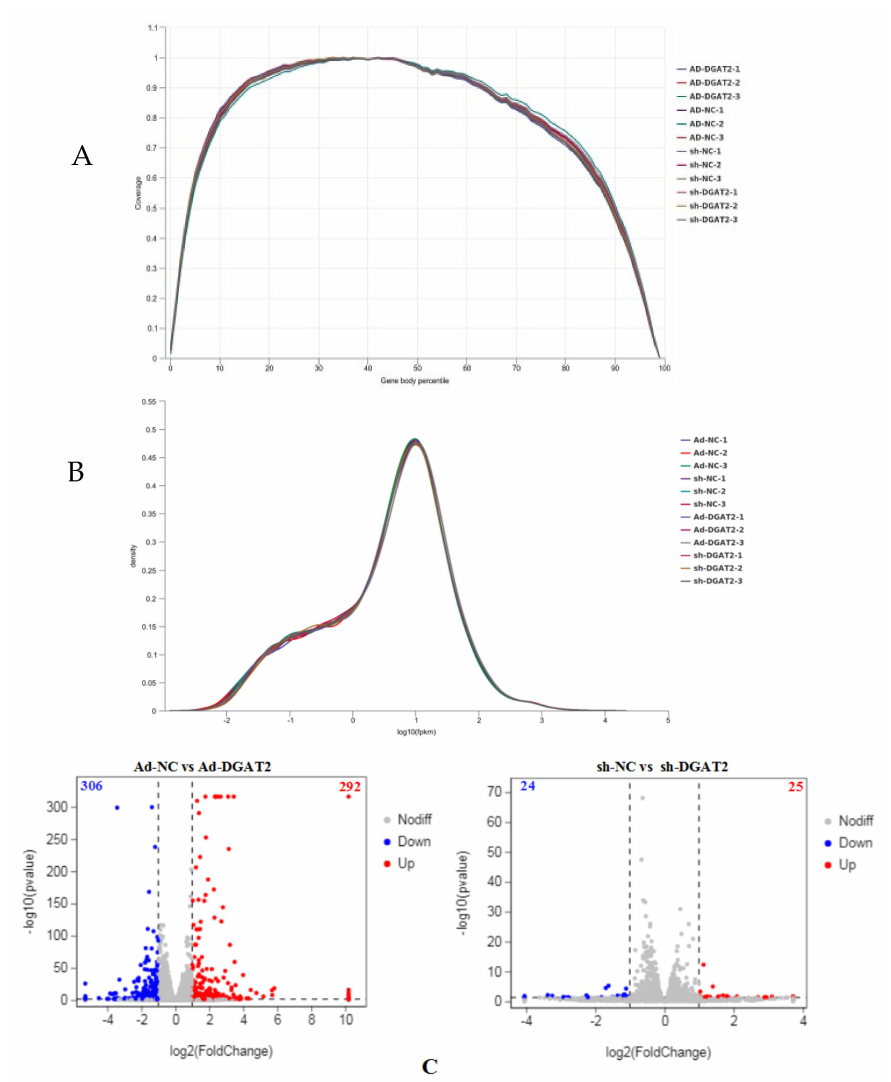
Figure 7. Screening of differentially expressed genes (DEGs) in BSCs infected with Ad-DGAT2/sh- DGAT2. BSCs were infected with Ad-NC, Ad-DGAT2, sh-NC, or sh-DGAT2 for 24 h;